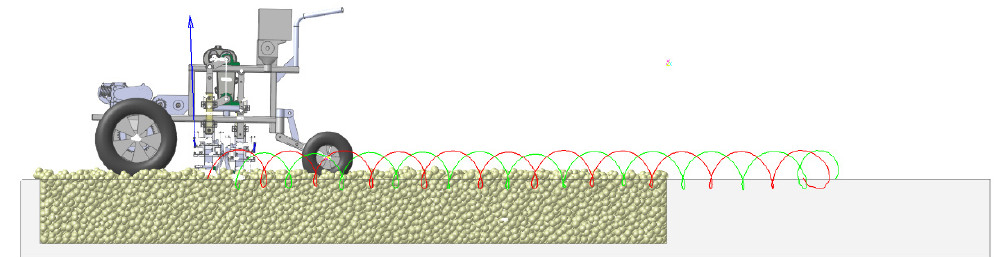
Figure 6. Simulation process of cavity seeding.